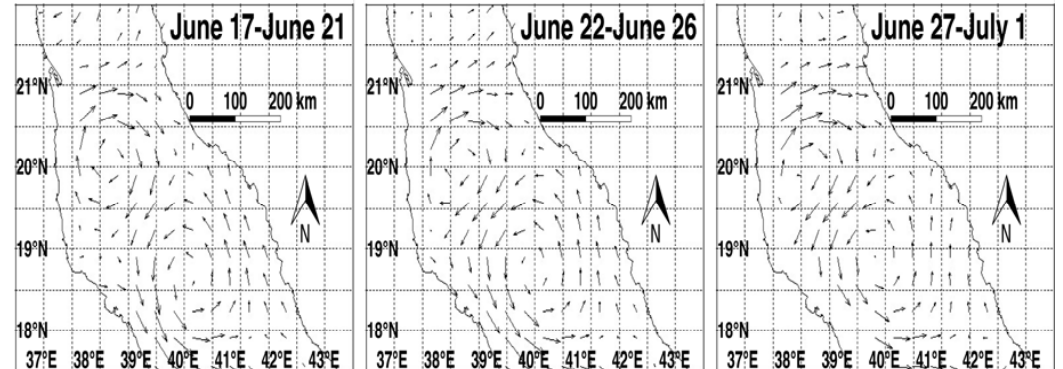
Figure 6. Ocean Surface Current Analysis Real-time (OSCAR) third-degree resolution ocean surface currents (m s − 1 ) for ( a ) 17 to 21 June, ( b ) 22 to 26 June, ( c ) 27 June to 1 July 2015.